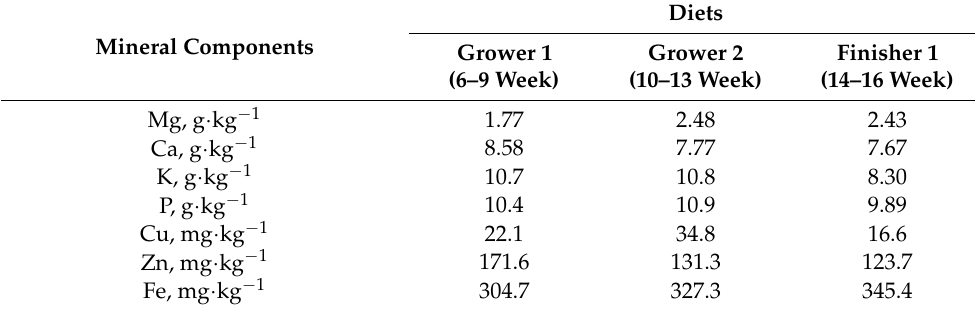
Table 2. Content of mineral components in the feed mixtures for turkeys.